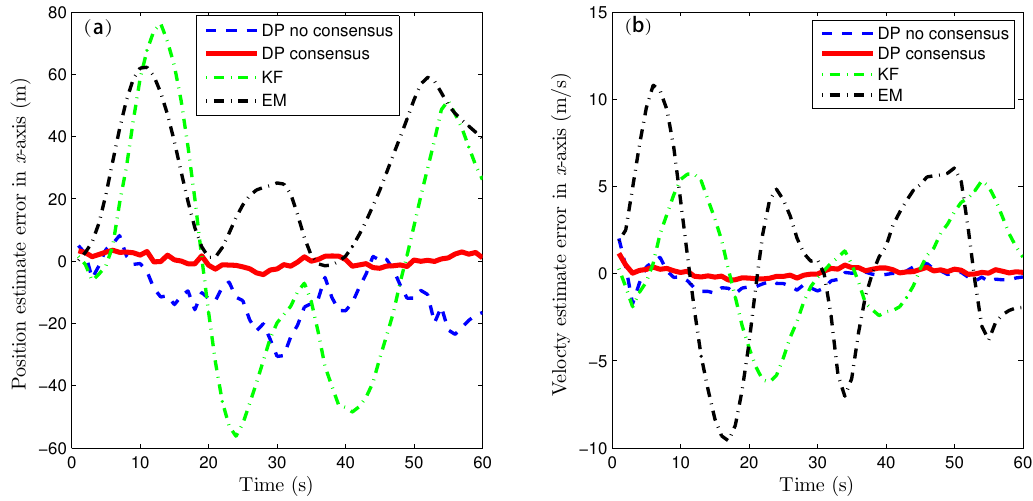
Figure 7. State estimation errors in the x direction using the KF, DP consensus, DP no consensus and EM methods for sensor 4. ( a ) position estimation; ( b ) velocty estimation.